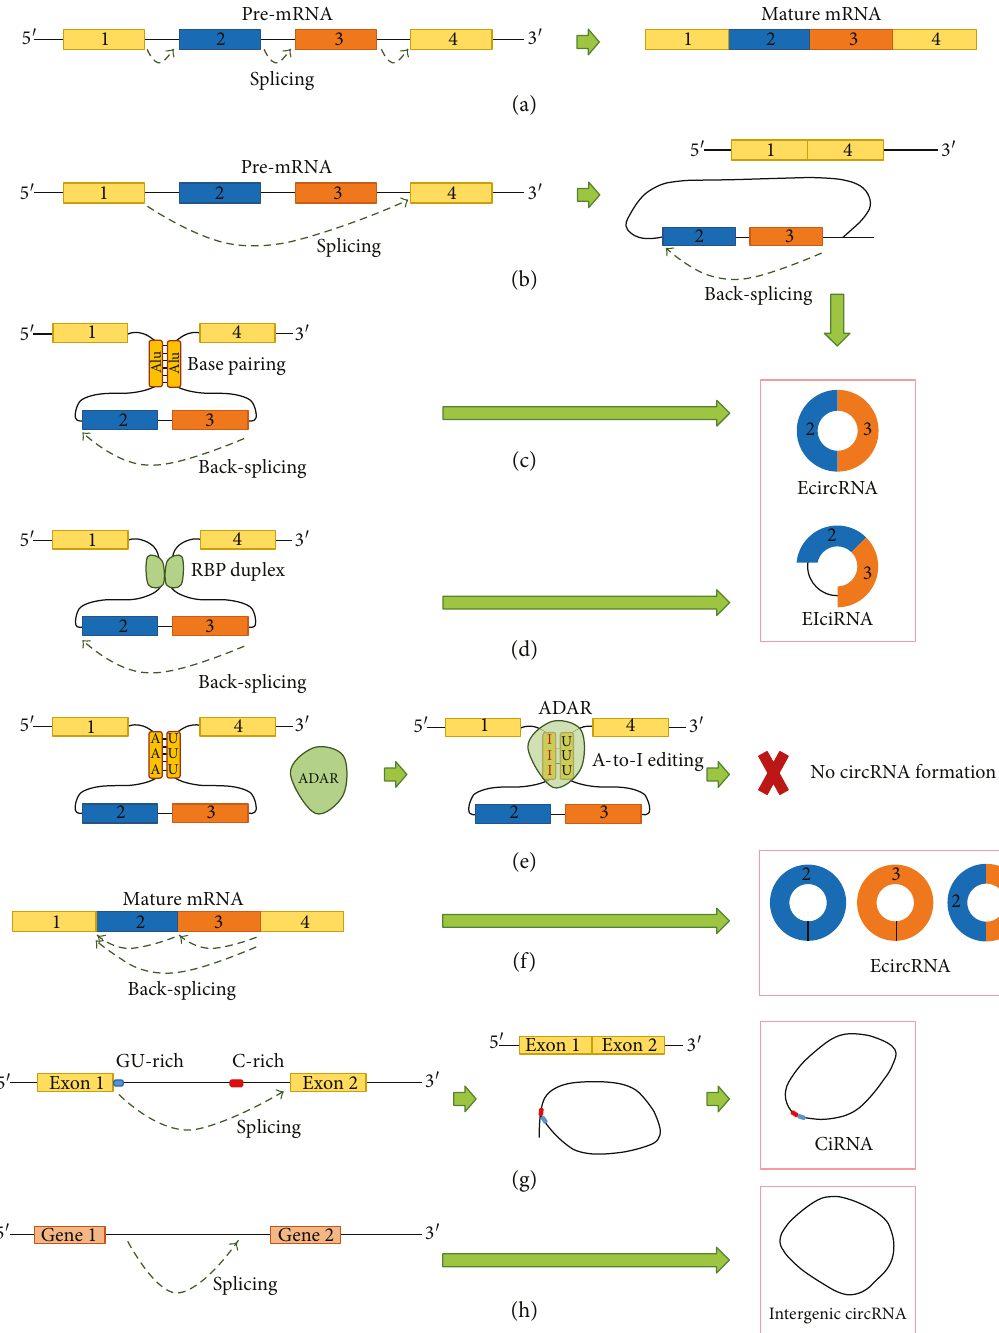
Figure 1: Schematic representation of circRNA biogenesis. (a) Canonical pre-mRNA splicing, yielding a mature mRNA molecule. (b) Lariat- driven circularization (exon skipping). Following canonical splicing, exons in exon-containing lariats undergo back-splicing and circularization, which results in the formation of ecircRNA or EIciRNA molecules. (c) Intron pairing-driven circularization, utilizing coupling of fl anking introns by direct base pairing between cis -acting regulatory elements that contain reverse complementary sequences (e.g., Alu repeats). Intron pairing is followed by back-splicing and exon circularization. (d) CircRNA biogenesis, mediated by trans -acting factors, such as RNA-binding proteins (RBPs) (e.g., QKI, MBL/MBNL1) that bind to speci fi c sequence motifs of fl anking introns on linear pre-mRNA, dimerize, and facilitate back-splicing and exon circularization. (e) Regulation of circRNA biogenesis by the RNA-editing enzyme ADAR. ADAR destabilizes intron base pairing interactions through the action of adenosine-to-inosine (A-to-I) editing, which impairs pre-mRNA looping and diminishes exon circularization. (f) Resplicing-driven circularization. EcircRNAs may be formed from mature mRNA exons that undergo back-splicing and circularization. (g) Formation of ciRNAs from intron lariats that escape the usual intron debranching and degradation, following the canonical pre-mRNA splicing. (h) Formation of intergenic circRNAs. This fi gure is adapted from Wang et al.